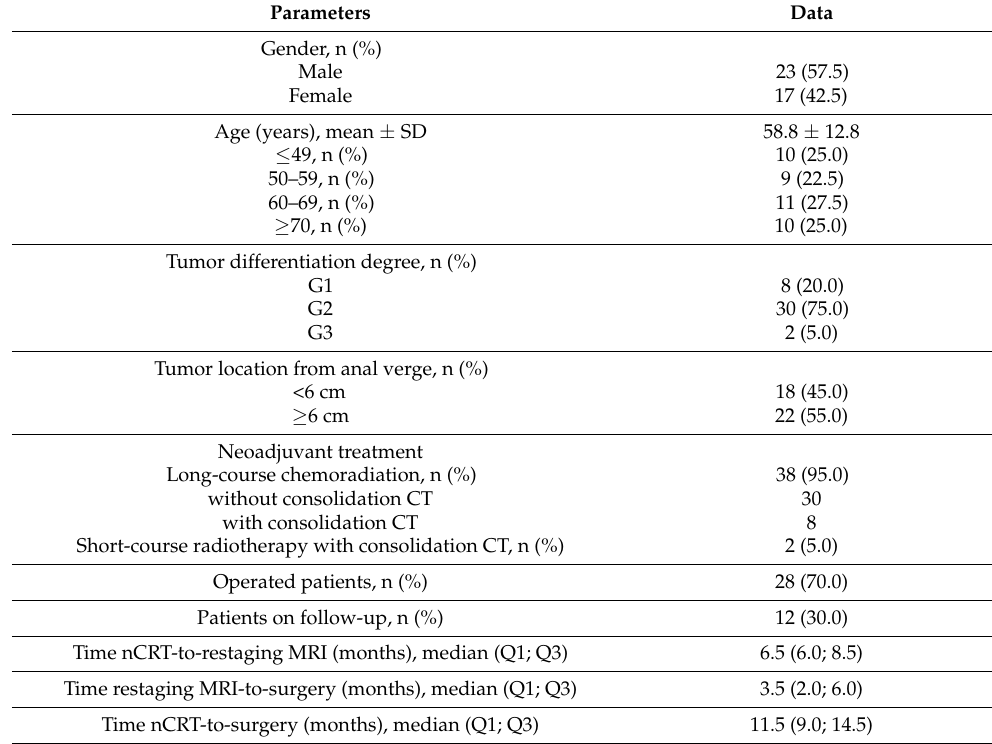
Table 4. Characteristics of patients enrolled.